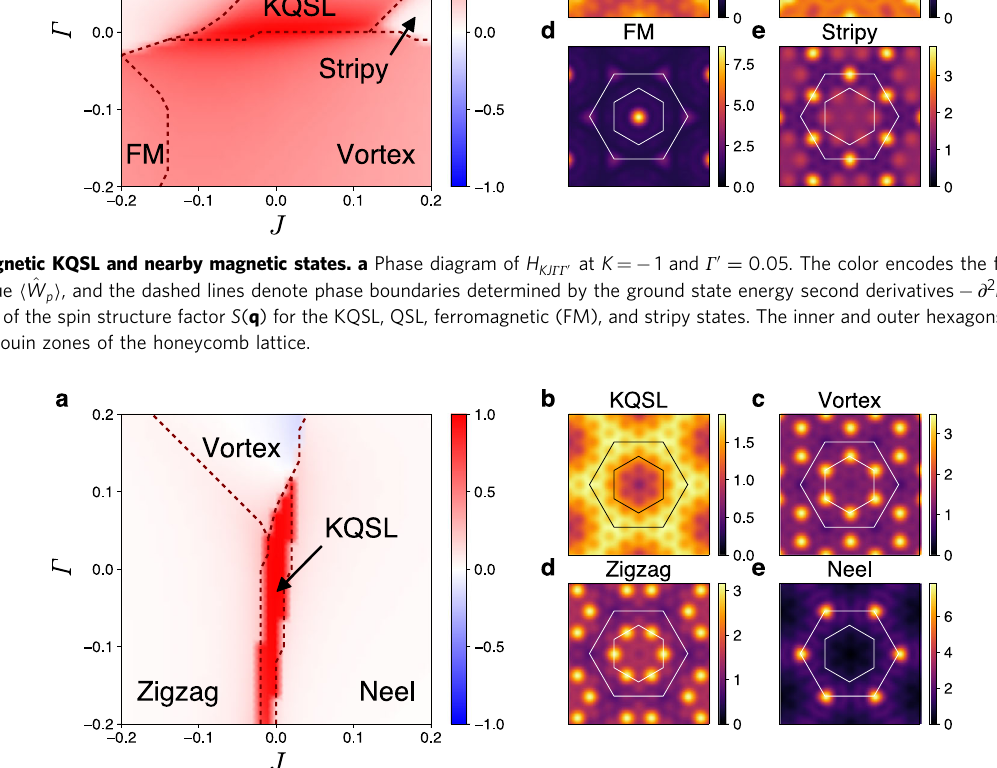
Fig. 7 Antiferromagnetic KQSL and adjacent magnetic states. a Phase diagram of H KJ ΓΓ 0 at K = 1 and Γ 0 ¼ (cid:3) 0 : 05. The color encodes the fl ux operator expectation value h ^ W p i , and the dashed lines denote phase boundaries determined by the ground state energy second derivatives − ∂ 2 E gs / ∂ ξ 2 ( ξ = J , Γ ). b – e Color maps of the spin structure factor S ( q ) for the KQSL, vortex, zigzag, and Neel states. The inner and outer hexagons denote the fi rst and second Brillouin zones of the honeycomb